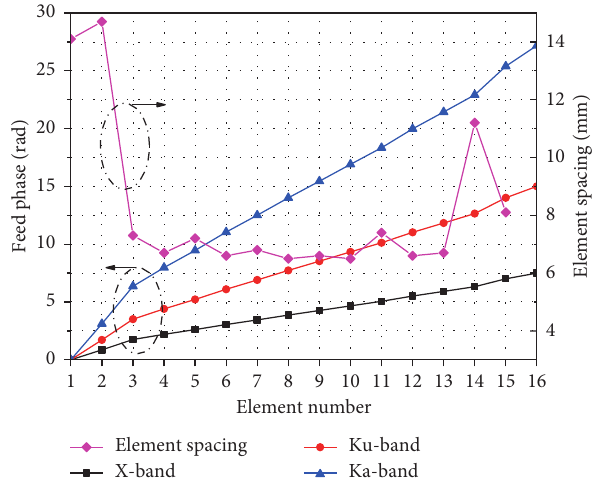
Figure 10: Optimization results of FRAA element spacing and port feed phases.